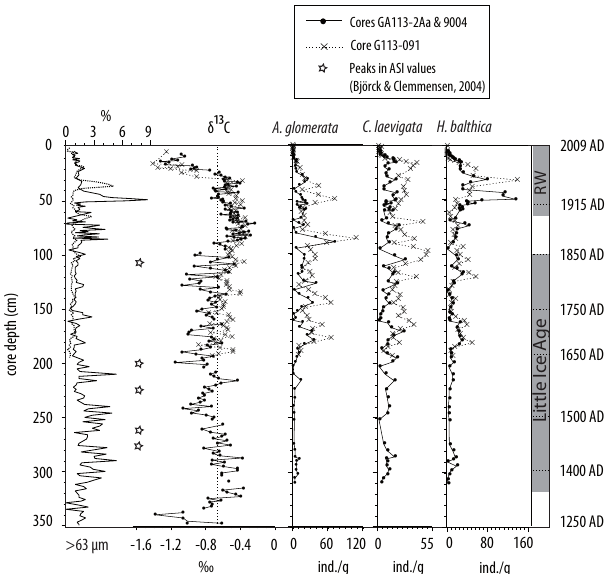
Fig. 3. The δ 13 C (‰) and foraminiferal (ind.g − 1 ) correlations be- tween cores GA113-2Aa, 9004 and G113-091. The abbreviation RW indicates the recent warming of the 1900s. The dates (yr) for time intervals on the right hand side are from Filipsson and Nord- berg (2004a) and Polovodova et al. (2011). The isotopic data for GA113-2Aa & 9004 are given after Filipsson and Nordberg (2010).